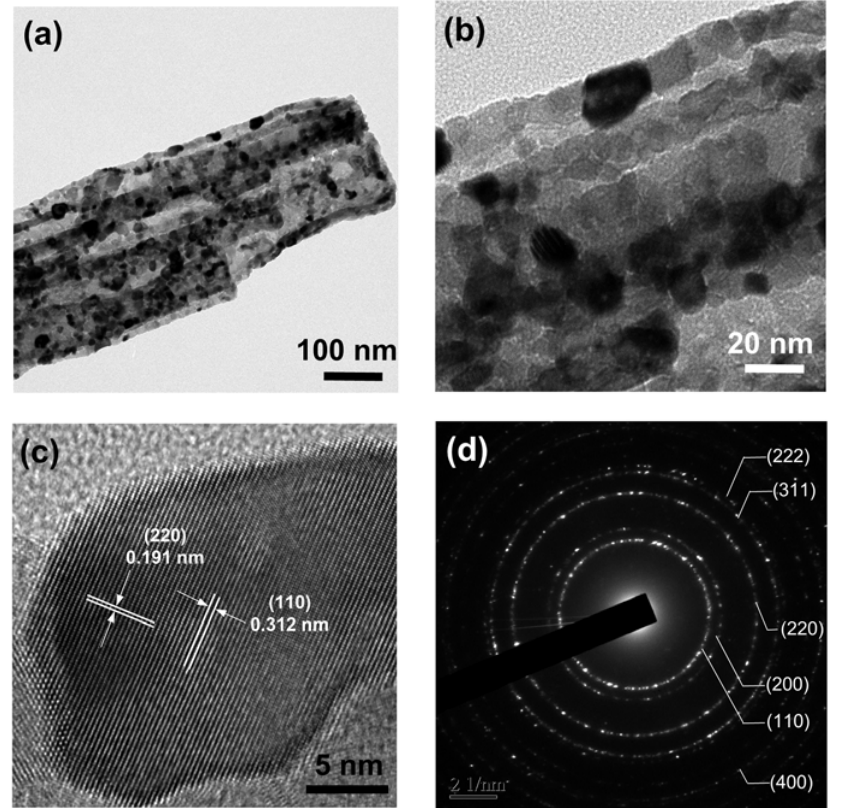
Figure 3. ( a , b ) TEM image of Ce-MOF under various magnifications, ( c ) lattice-resolved image of CeONB and ( d ) SAED pattern of CeONB.